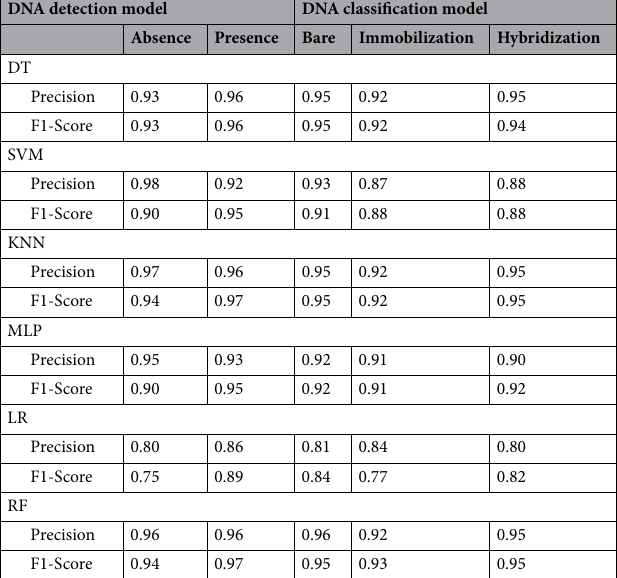
Table 1. Performance comparison of DNA detection and DNA classification.